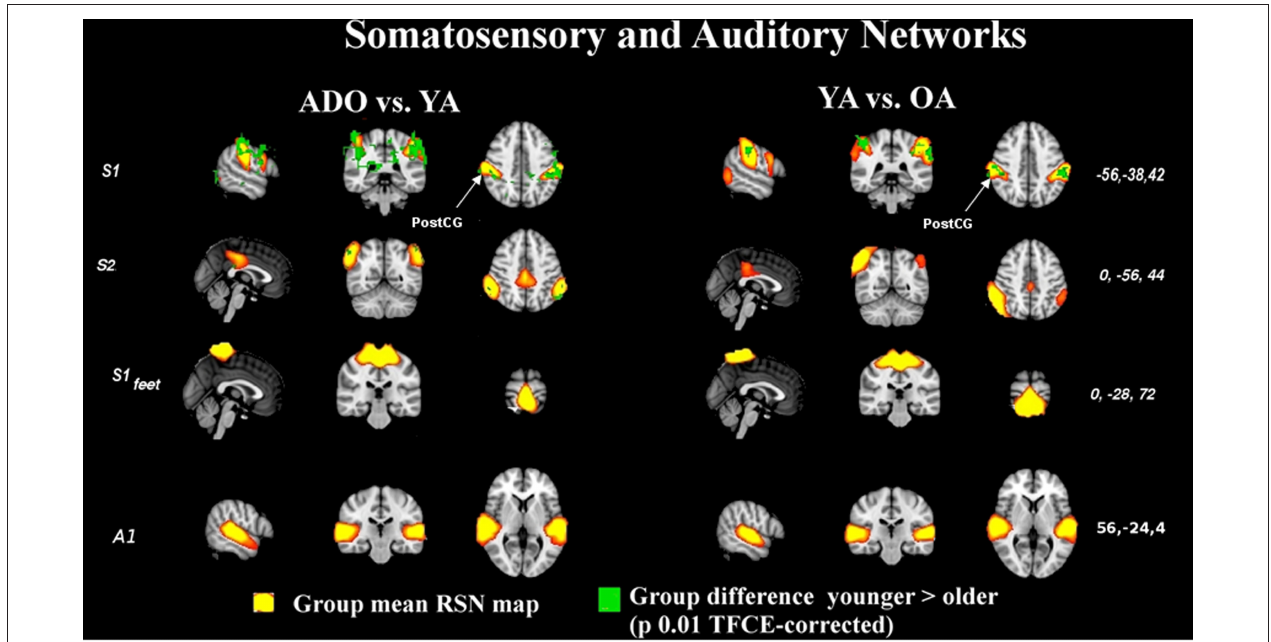
Figure 5 | Auditory and somatosensory results shown in the manner as Figure 1. S1 alters through life but the rest of the sources do not alter significantly through time. CG, central